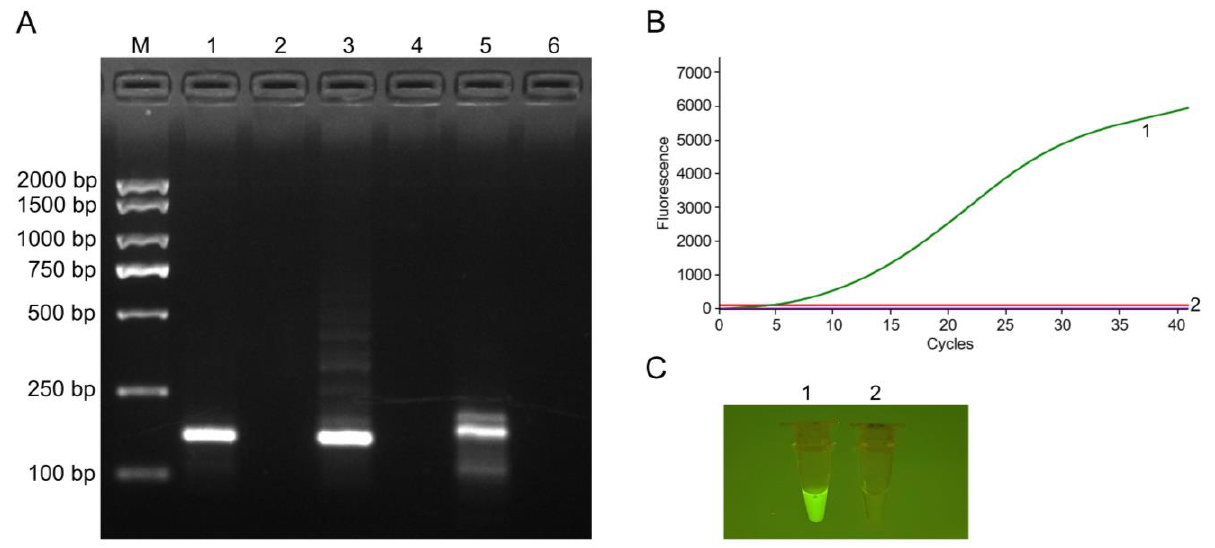
Figure 2. Primer screening and RF-RT-RAA assay establishment. ( A ) Agarose gel electrophoresis results of RT-RAA products using different primer pairs. M: DL2000 DNA marker; 1, 3, 5: Positive reactions using primer pairs of ORF6 F1/ORF6 R1, ORF6 F2/ORF6 R2, ORF6 F3/ORF6 R3, respec- tively; 2, 4, 6: Negative controls for primer pairs of ORF6 F1/ORF6 R1, ORF6 F2/ORF6 R2, ORF6 F3/ORF6 R3, respectively. ( B ) Amplification results of RF-RT-RAA through real-time fluorescence read-out. ( C ) Amplicons of RF-RT-RAA observed with the naked eye under blue light. The image was captured by a mobile phone camera. Curve or tube 1: Positive reaction using the primer pair ORF6 F1/ORF6 R1 and a probe; curve or tube 2: Negative control.